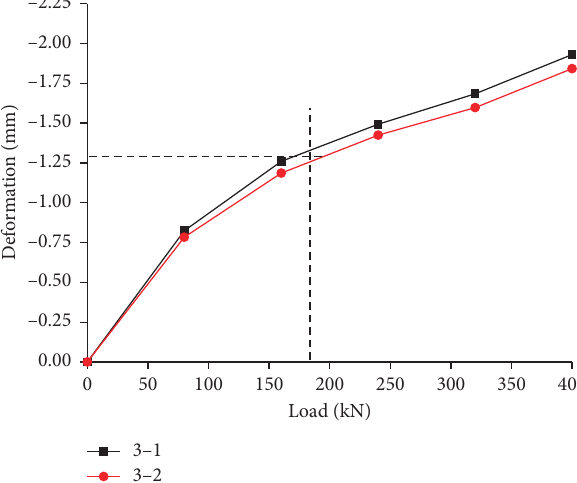
Figure 15: Load-interlayer deformation curves of unballasted tracks labeled